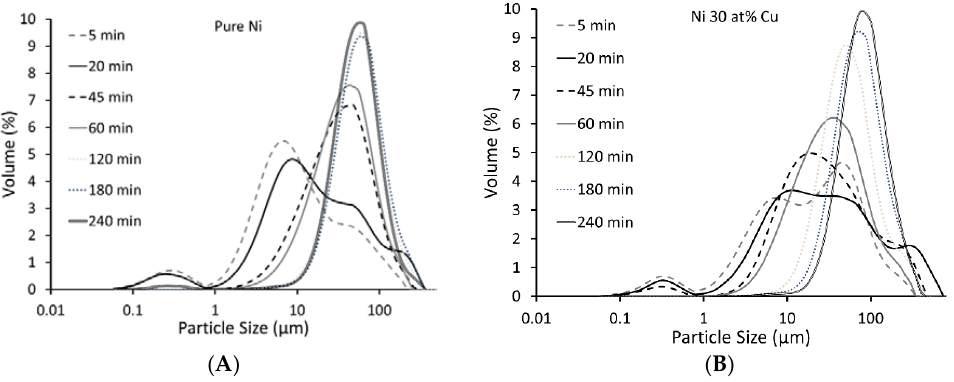
Figure 9. Particle size distributions for ( A ) Ni and ( B ) Ni 30 at % Cu after milling times indicated.